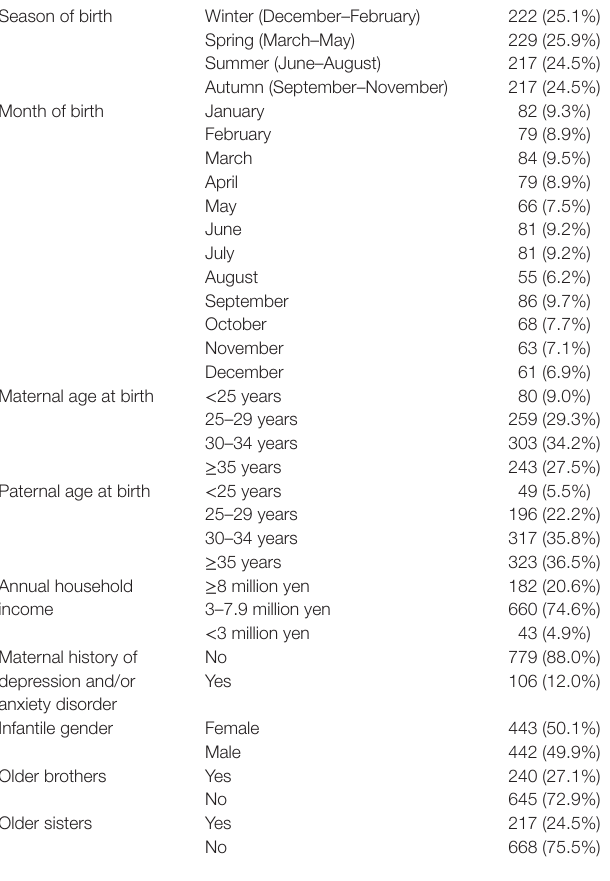
TaBle 1 | number and proportion of predictors and covariates ( N = 885). Season of